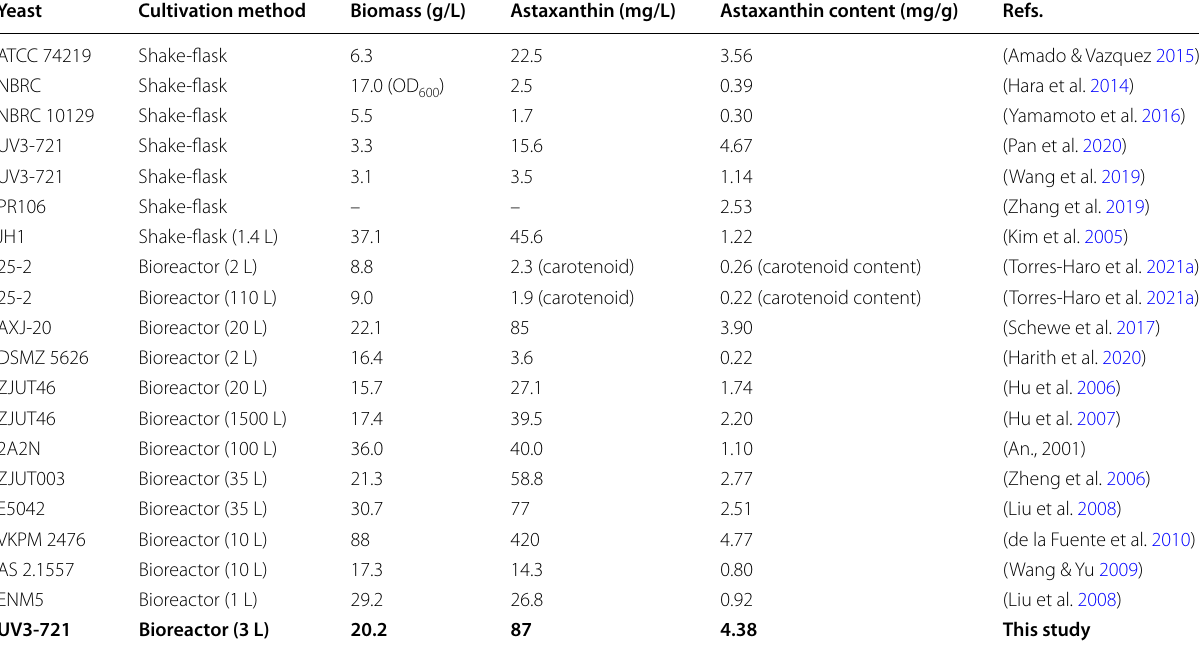
Table 1 Comparison of biomass, astaxanthin titer, and astaxanthin content in X. dendrorhous with those reported in the literature Yeast Cultivation